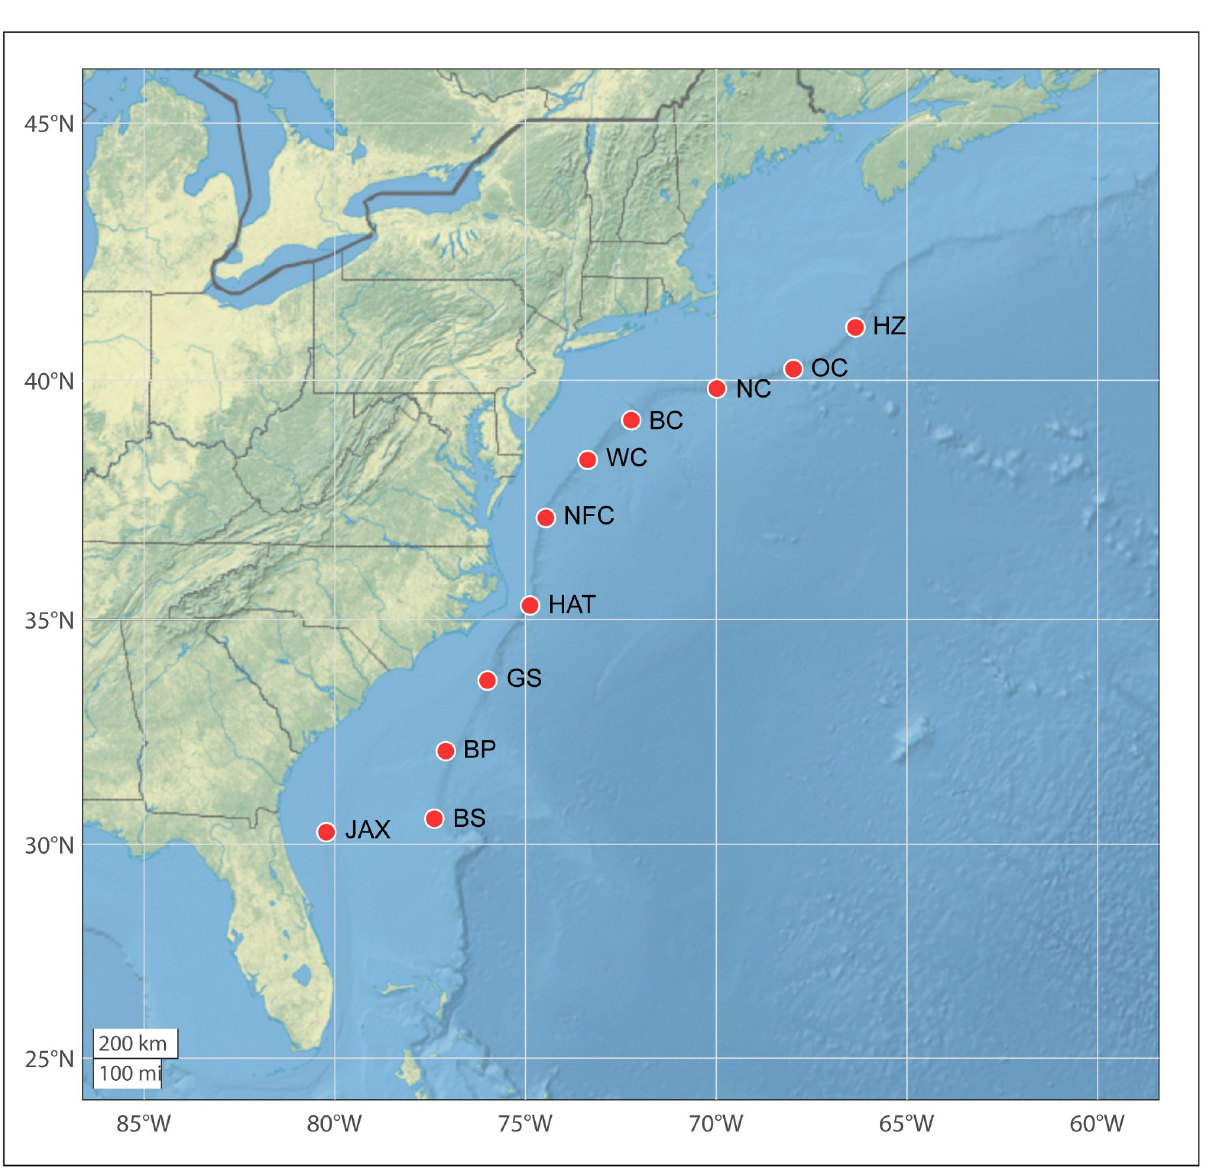
Fig 1. Western North Atlantic study area with long-term autonomous passive acoustic monitoring sites (red circles) and associated site name abbreviations. HZ = Heezen Canyon; OC = Oceanographer’s Canyon; NC = Nantucket Canyon; BC = Babylon Canyon; WC = Wilmington Canyon; NFC = Norfolk Canyon; HAT = Hatteras; GS = Gulf Stream; BP = Blake Plateau; BS = Blake Spur; JAX = Jacksonville.